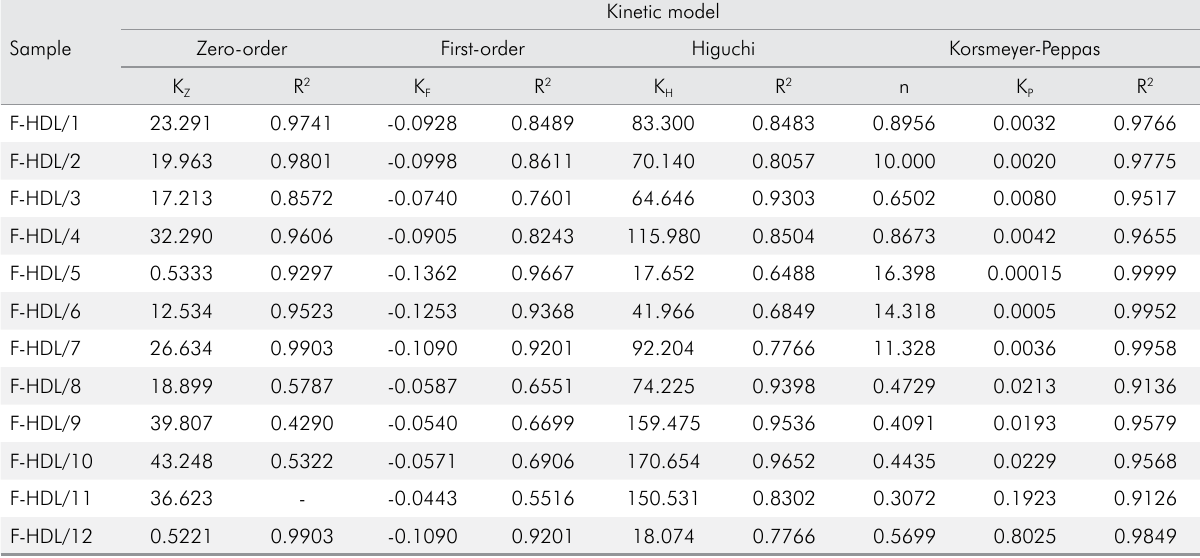
Table 3. Estimated kinetic parameters of drug release (Neutral